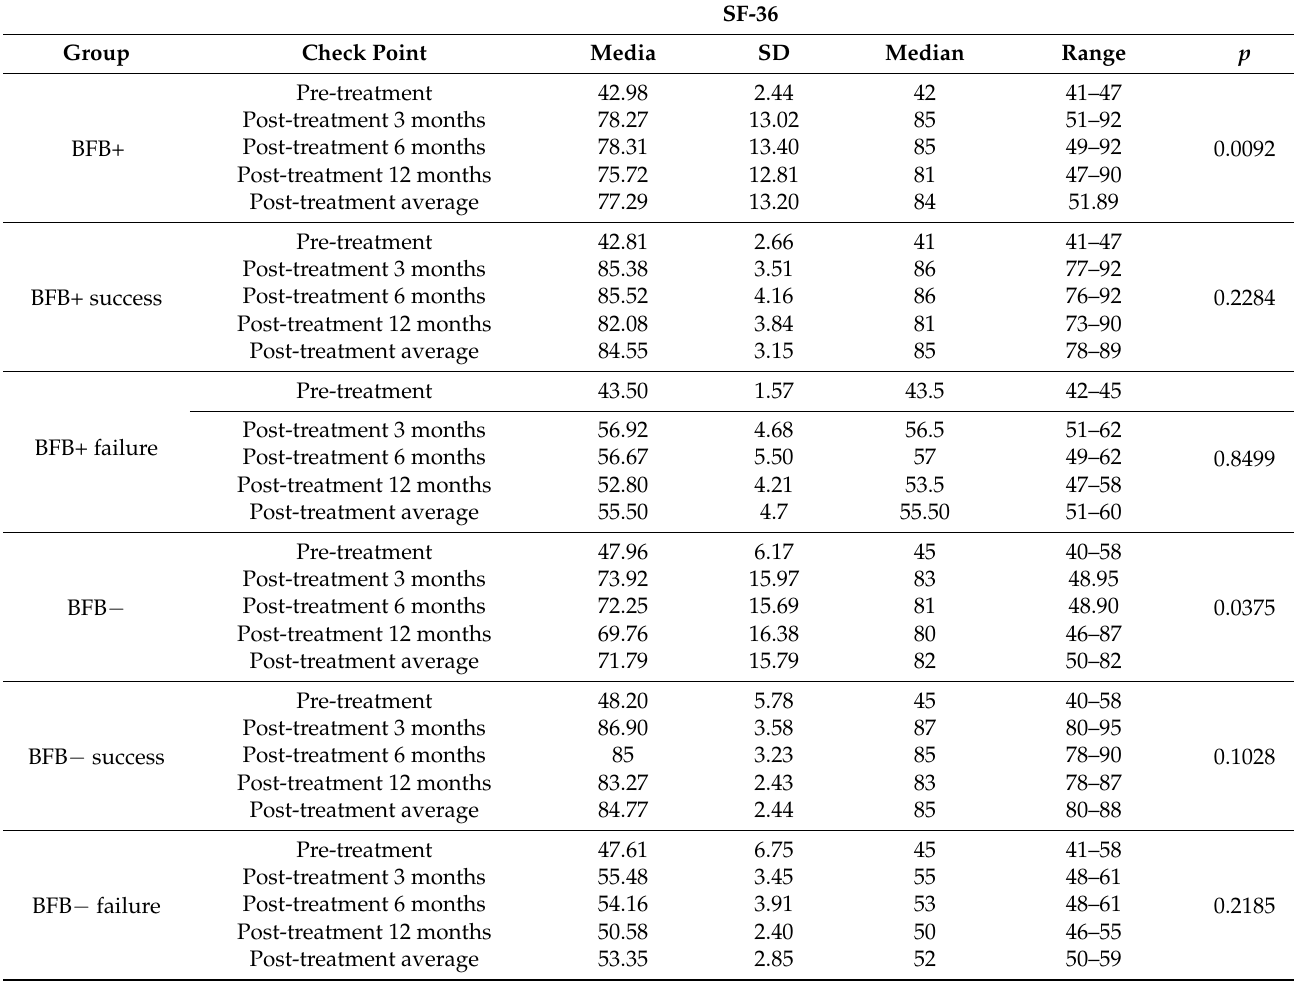
Table 2. SF-36 scores in BFB+ and BFB −